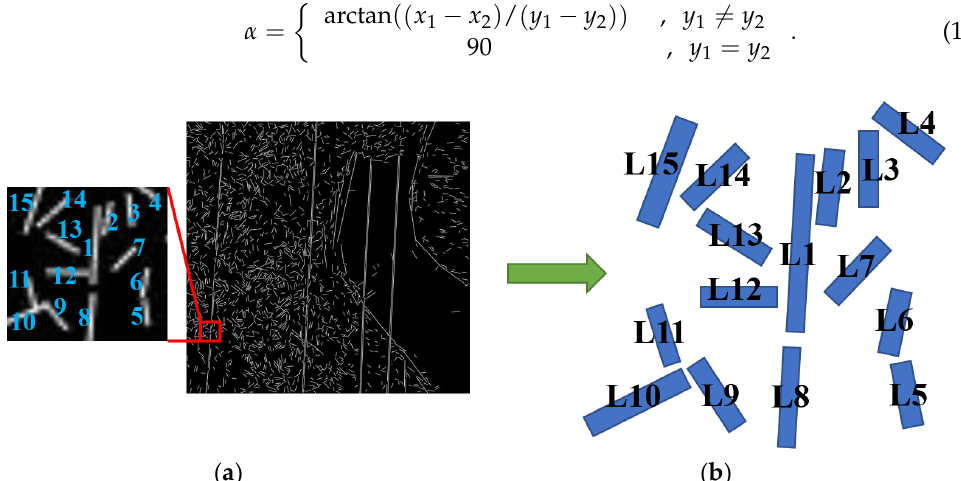
Figure 6. Numbered line segments. ( a ) Detection results of multi-scale LSD; ( b ) Number of local segments.